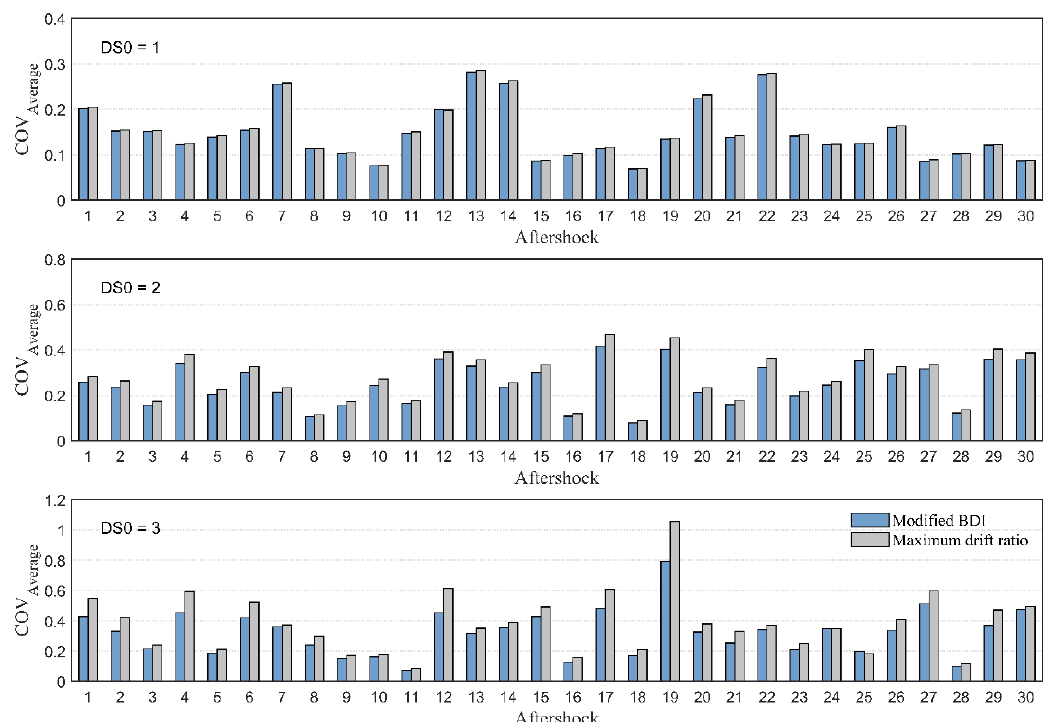
Figure 13. Variability of collapse capacity derived from different mainshocks that induce initial damage states via different damage indices.